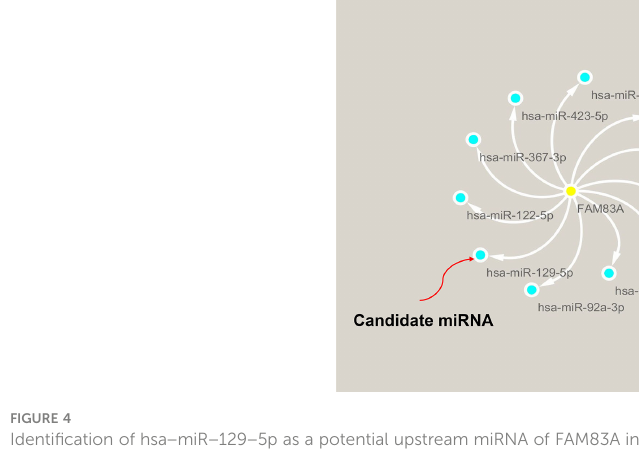
Cytoscape (Figure S2). Differential expression and prognostic values of these lncRNAs in PC analyzed by the GEPIA database showed that only AL049555.1 (RP3-523K23.2, ENSG00000261116) was signi fi cantly upregulated in PC compared with normal controls (Figure 5A). Increased AL049555.1 expression indicated poorer OS and relapse-free survival in PC, even though P > 0.05 in the latter (Figures 5B – C). AL049555.1 was strongly negatively correlated with hsa-miR-129-5p (r = -0.393, P value < 0.001) and strongly positively correlated with FAM83A (r = 0.518, P value < 0.001) (Figures 5D, E). Meanwhile, hsa-miR-129-5p was strongly negatively correlated with FAM83A (r = -0.322, P value < 0.001) (Figure 5F). This survival and correlation analysis suggested that the novel lncRNA, AL049555.1 , may be the upstream lncRNA of the hsa-miR-129-5p/ FAM83A axis in PC. Finally, in the qRT-PCR assay, hsa-miR-129- 5p was signi fi cantly lowly expressed in tumorous PC tissues compared to that in normal controls, and AL049555.1 was